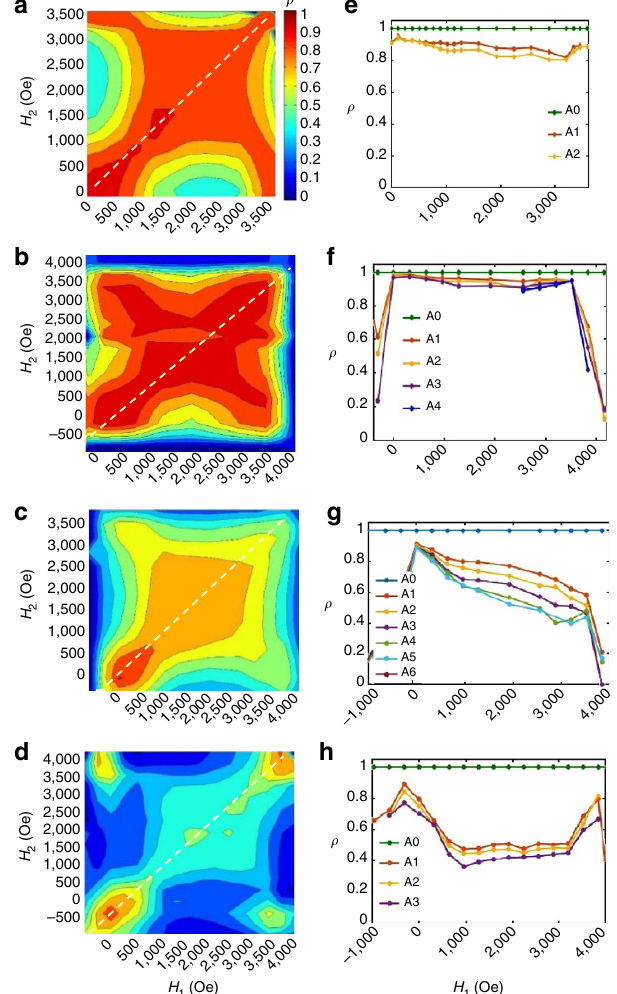
Figure 4 | Dependence of correlation maps and associated diagonal slices with cooling field H FC . ( a – d ) Correlation maps r (H 1 , H 2 ) measured at 20K on the ascending branch after one cycle (A1 map) under different cooling fields H FC (cooling starting at 400K): ( a ) H FC ¼ 0 (ZFC); ( b ) H FC ¼ 2,240Oe; ( c ) H FC ¼ 2,560Oe; and ( d ) H FC ¼ 3,200Oe. ( e – h ) Associated diagonal slices through the maps along the dotted line. Each graph includes several measured cycles (up to six cycles for H FC ¼ 2,560Oe) using the notation A0, A1, A2 and so on. In this notation, the letter A stands for the ascending branch and the index corresponds to the number of cycles separating the two correlated